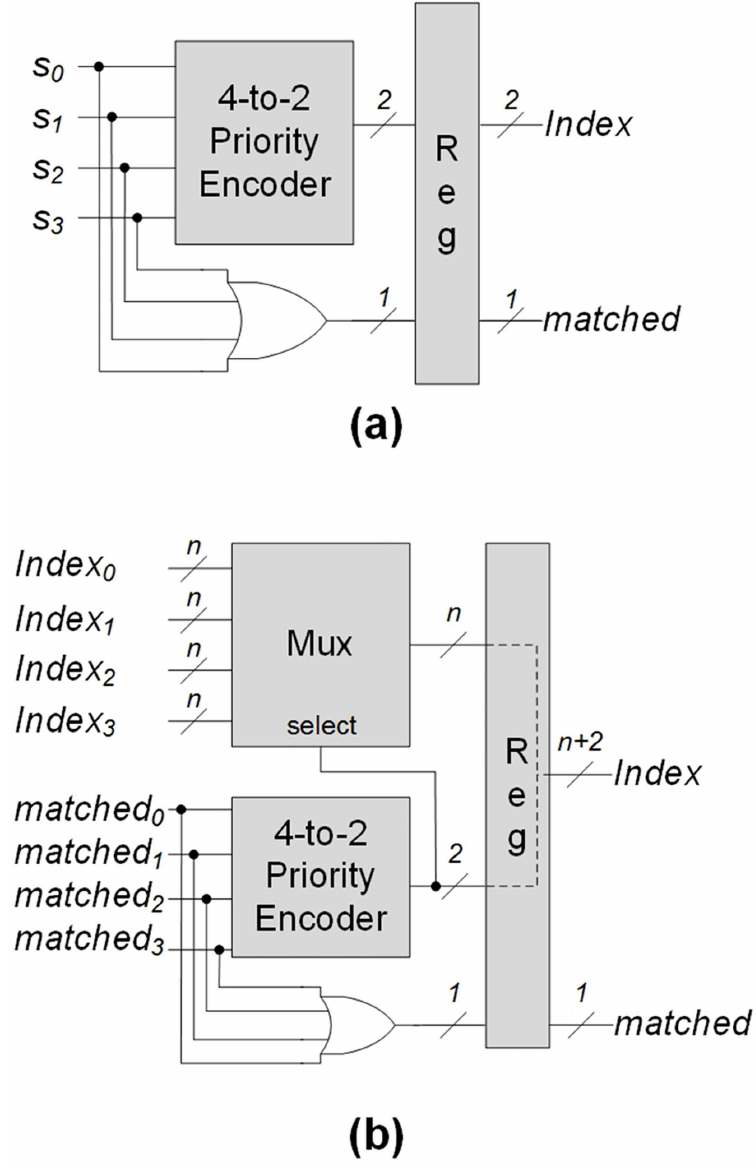
Fig 6. Blocks of pipelined priority encoder: (a) an unit block for getting information of output states; (b) a block for the stage with four n -bit indexes and matched